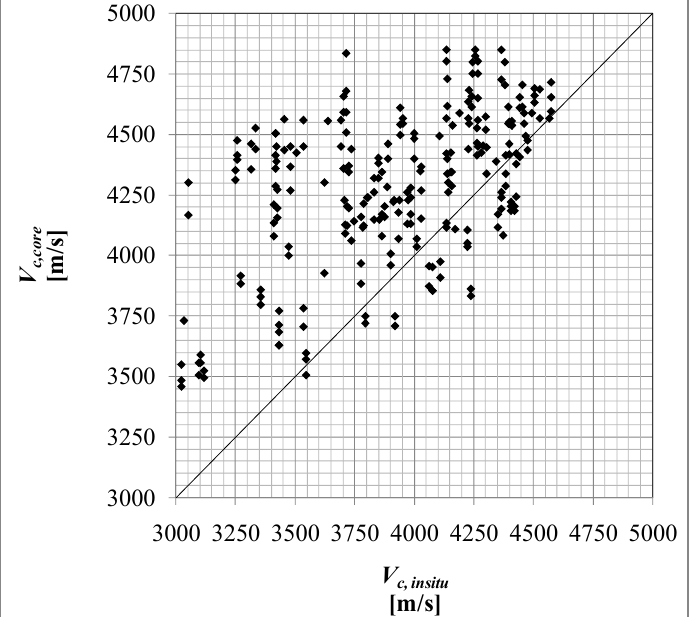
Figure 10. Direct measurement of ultrasonic velocity on single concrete samples.